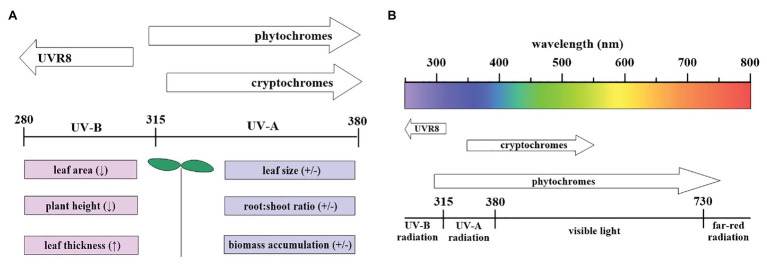

(A) Plant responses to UV-A and UV-B radiation, with both positive and negative effects induced by UV-A radiation. (B) Plant photoreceptors involved in flower initiation with their corresponding spectral regions, adapted from Folta and Carvalho (2015) and Jones (2018).